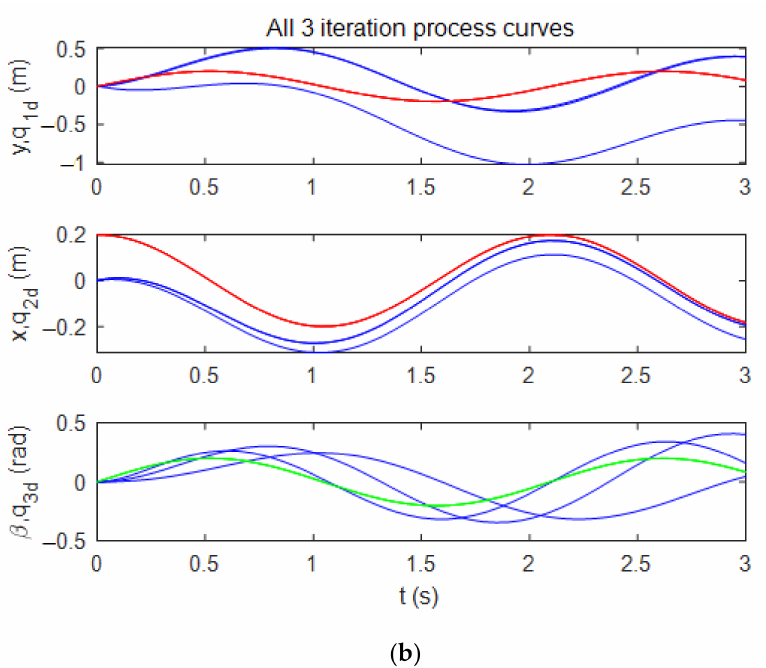
Figure 6. The uncontrolled time responses under U = 10 ms − 1 ( a ), and the variable fluctuations of all three iterations during tracking process ( b